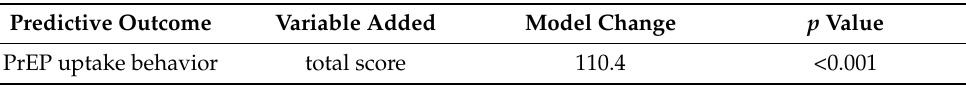
Table 8. Hierarchical regression analysis of PrEP adherence questionnaire score for predicting PrEP uptake